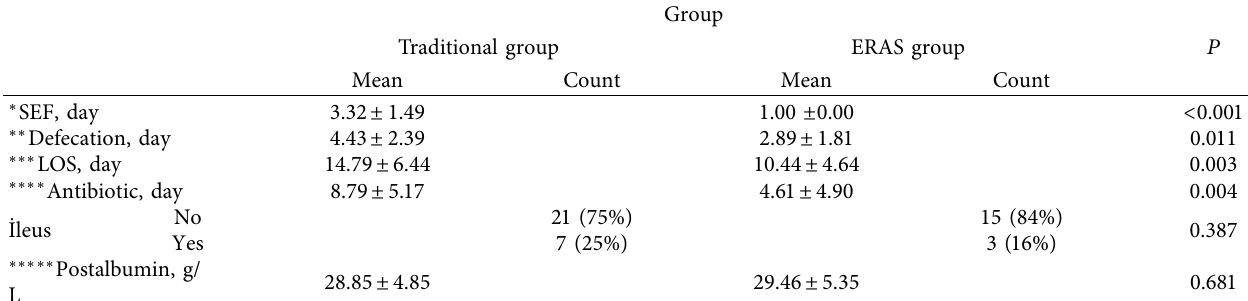
Table 2: Postoperative